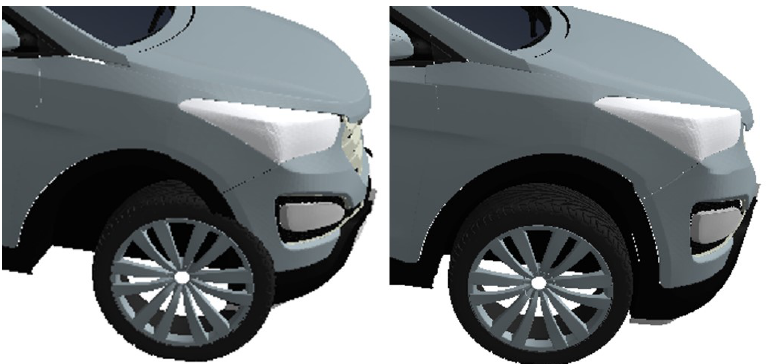
Figure 10. Comparison between translated (gray) and deformed bumper (red).